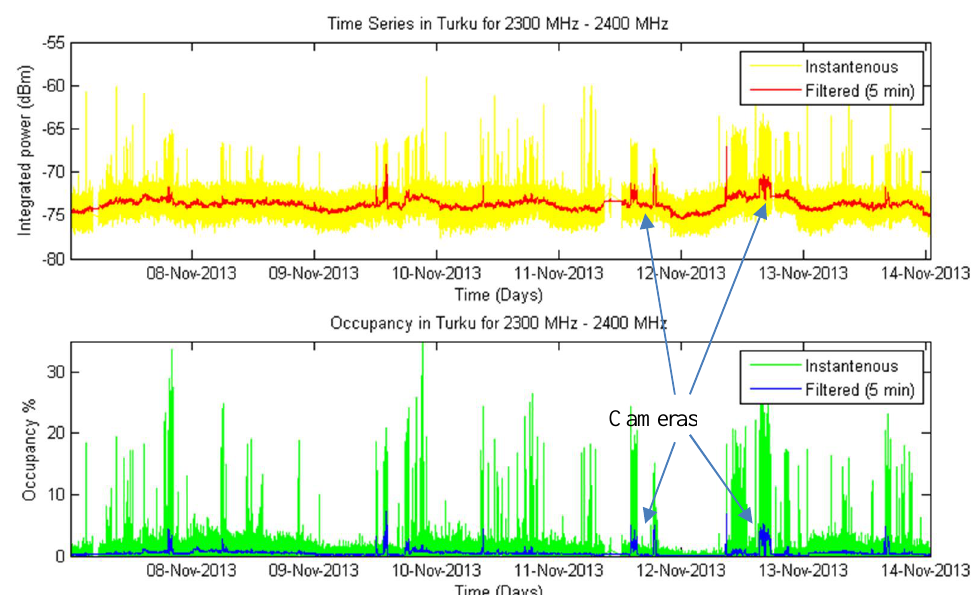
Figure 6 . Integrated power time series and percentage occupancy at Turku (Nov 7 th - 14 th